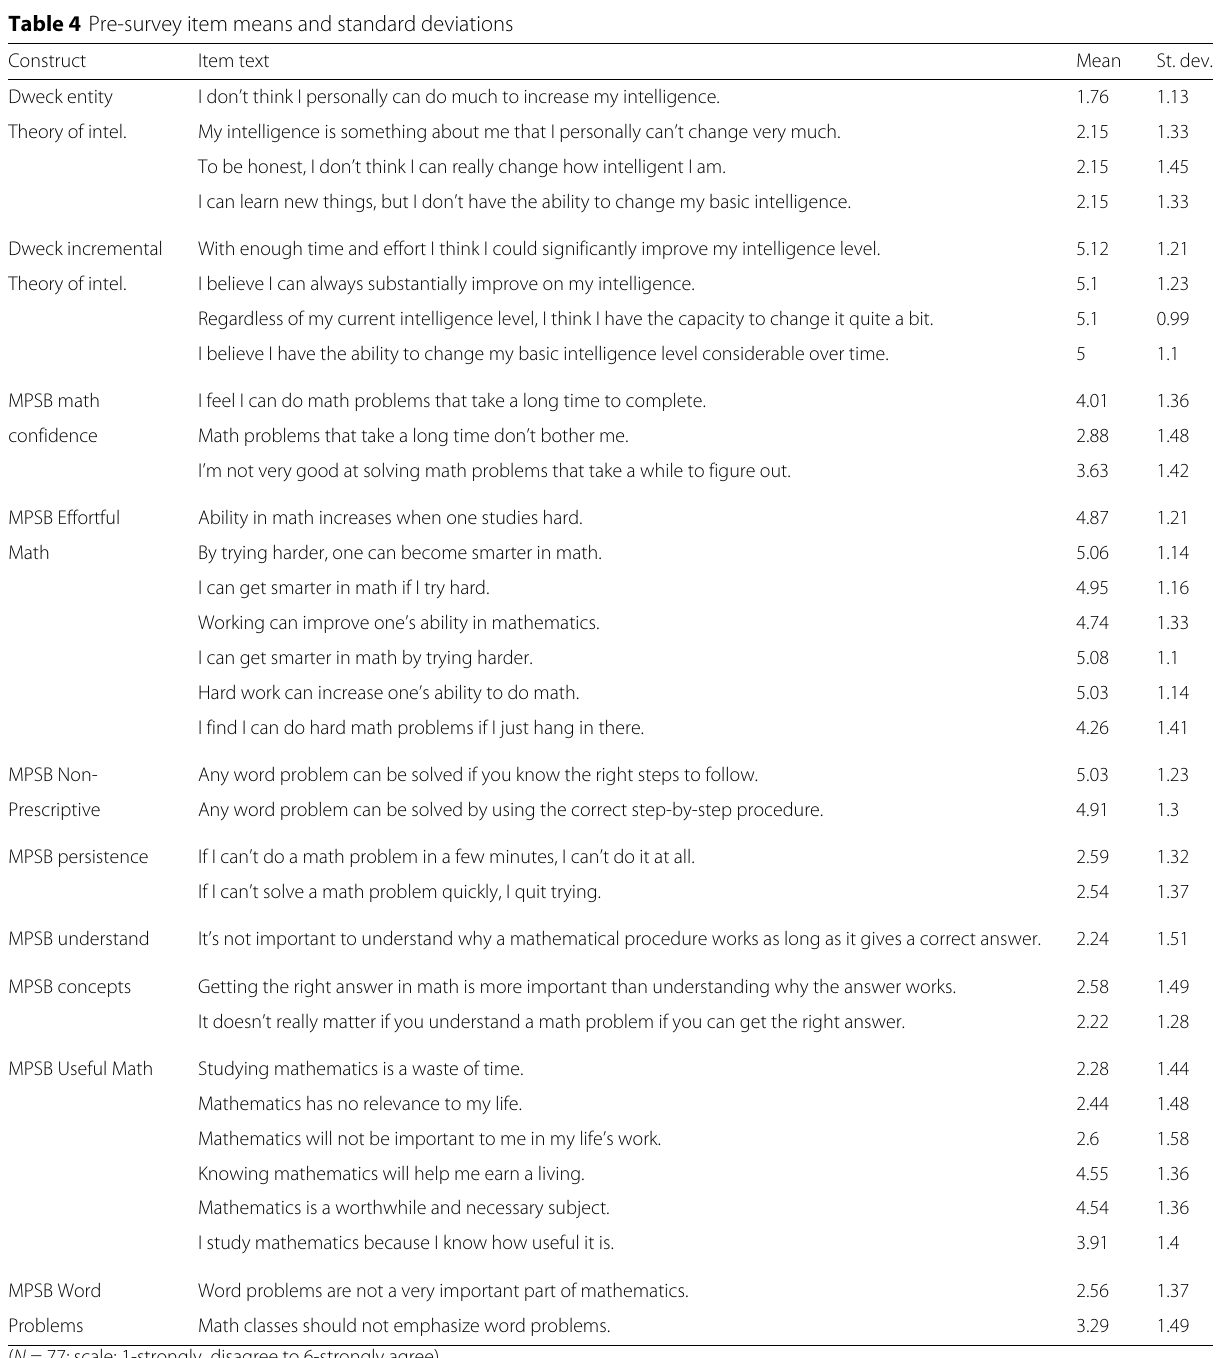
Table 4 Pre-survey item means and standard deviations